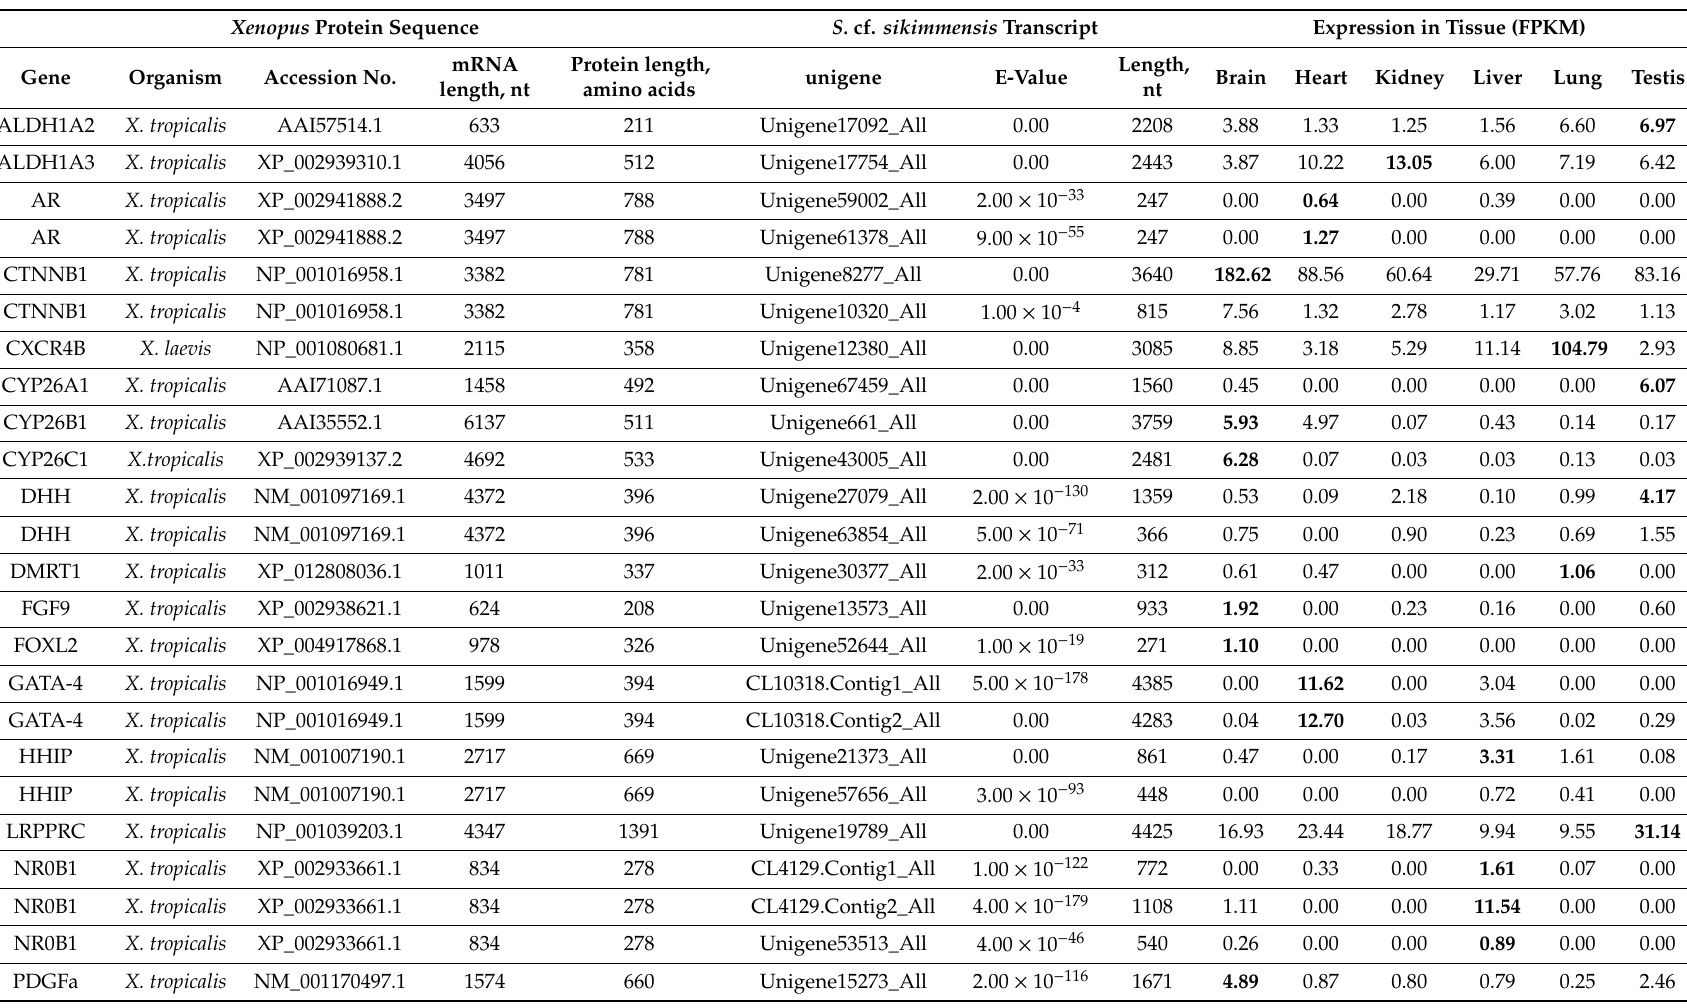
Table 3. Sex-determining and sex di ff erentiation gene inventory and homologous Scutiger cf. sikimmensis transcripts. Gene expression is calculated as FPKM based on RNA-seq data from six tissues; the highest gene expression level per gene over all tissues is indicated in bold. CL = cluster of several